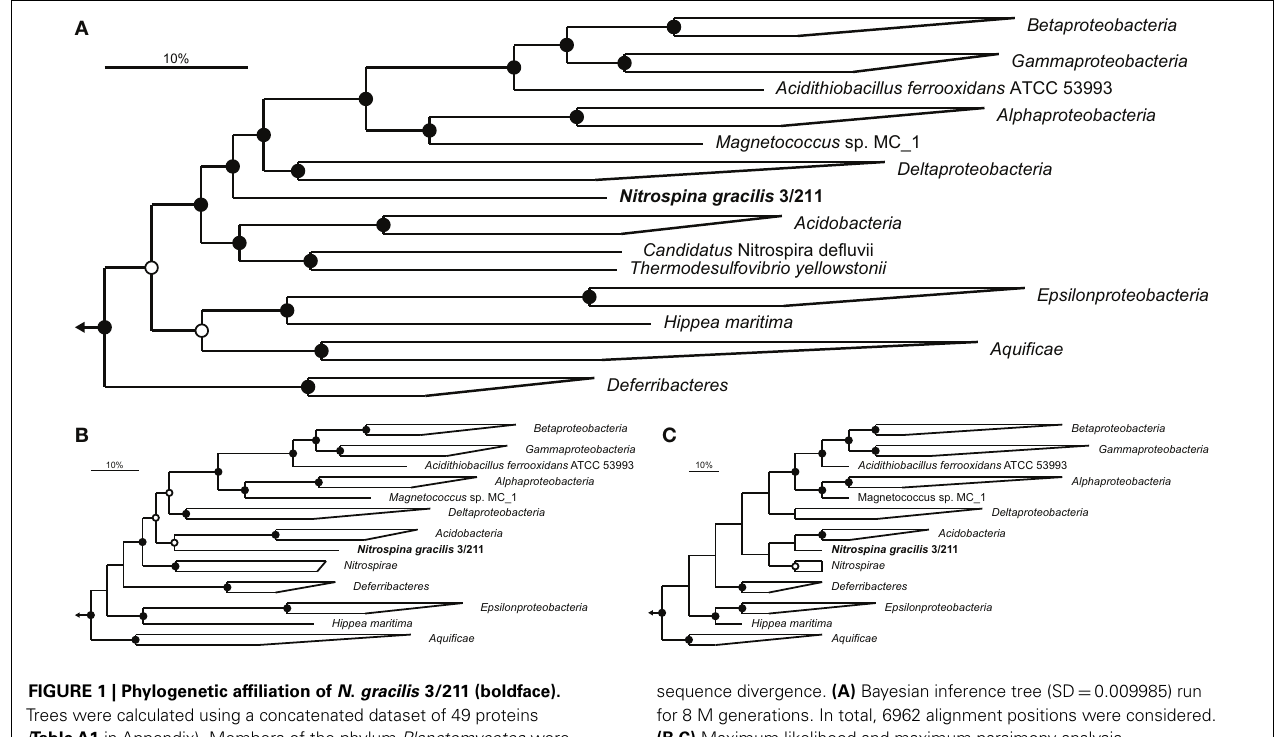
sequence divergence. (A) Bayesian inference tree (SD = 0.009985) run for 8 M generations. In total, 6962 alignment positions were considered. (B,C) Maximum-likelihood and maximum-parsimony analysis, respectively, with 100 bootstrap iterations, using 7629 alignment